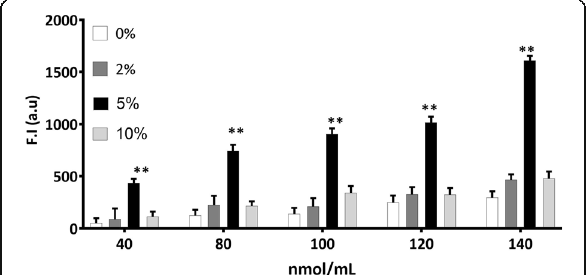
Fig. 2 4 T1 cellular uptake studies. An amount of 1 × 10 4 4 T1 cells were seeded in a 48 well plate. After 24 h, cells were exposed to different concentration of fluorescently labeled CLENs and incubated with the cells for an additional 24 h. The most significant cellular uptake was observed with 4 T1 cells compared to the other breast cells. The least amount of cellular uptake was observed with the ovarian cancer (negative control) cell line, SK-OV-3. Data are presented as mean ± S.D.; ( n = 6)